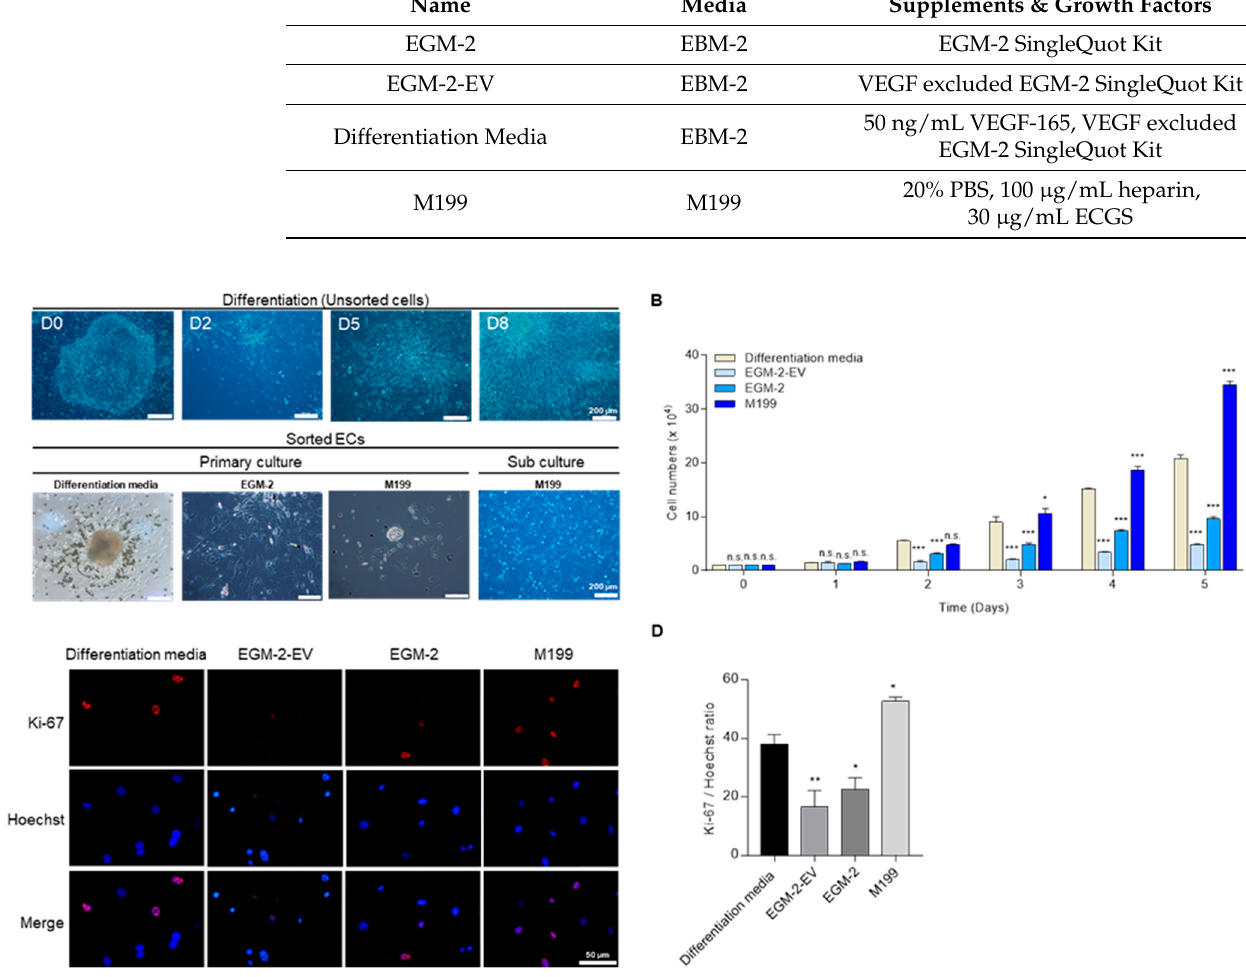
Figure 2. The proliferation of sorted ECs. ( A ) Morphologies of pEpiSCs and differentiated cells in differentiation media on the days 0, 2, 5, 8, respectively. Sorted ECs were cultured in differentiation media, EGM-2, or M199 culture system on 0.2% gelatin for the primary culture. Primary sorted ECs cultured in differentiation media were transferred to M199 culture system for sub-culture. ( B ) Pro-liferation rates of 1.0 × 10 4 of sorted ECs were evaluated in four culture conditions. Values presented